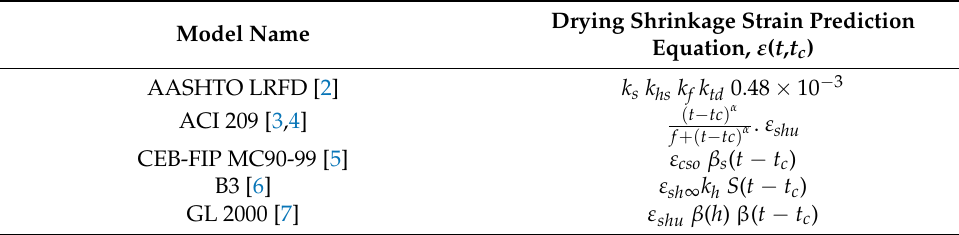
Figure 4. Drying shrinkage specimens. Table 6. Drying shrinkage strain prediction models.